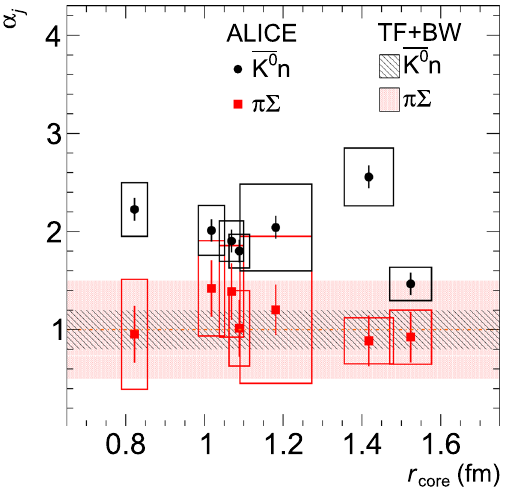
Fig. 7 Scalingfactor( α j )forK 0 n(blackcircles)and π (cid:3) (redsquares) extracted from the different fits of the K − p correlation function as a function of the core radius r core extracted for pp, p–Pb and Pb–Pb col- lisions. The vertical error bars and boxes represent the statistical and systematic uncertainties on the extracted parameters, respectively. The widths of the boxes represent the systematic uncertainty associated to each extracted r core . The black and red bands represent the uncertainty coming from the yield estimates in TF and the variations applied in the BW kinematics summed in quadrature as described in the text for K 0 n and π (cid:3) ,